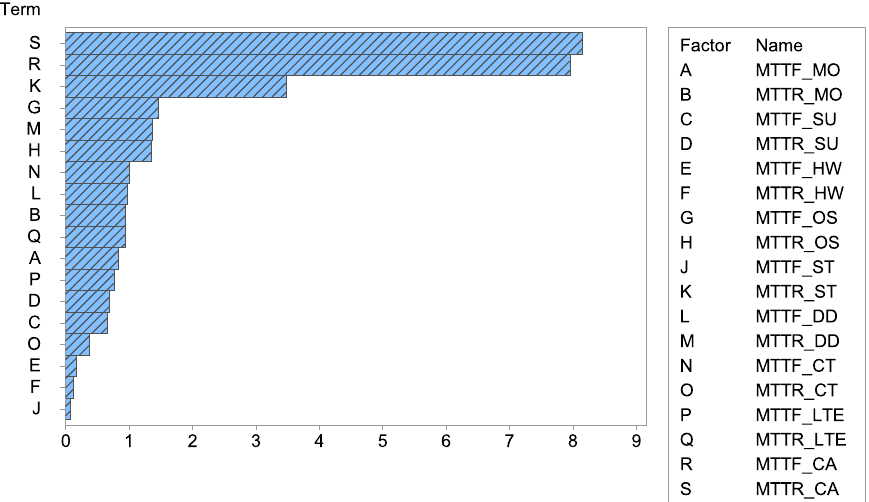
Figure 6. Influence of factors on the availability metric.